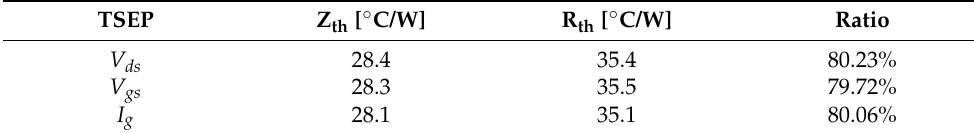
Table 7. Comparison of Zth and Rth values of all TSEP @3.6A.